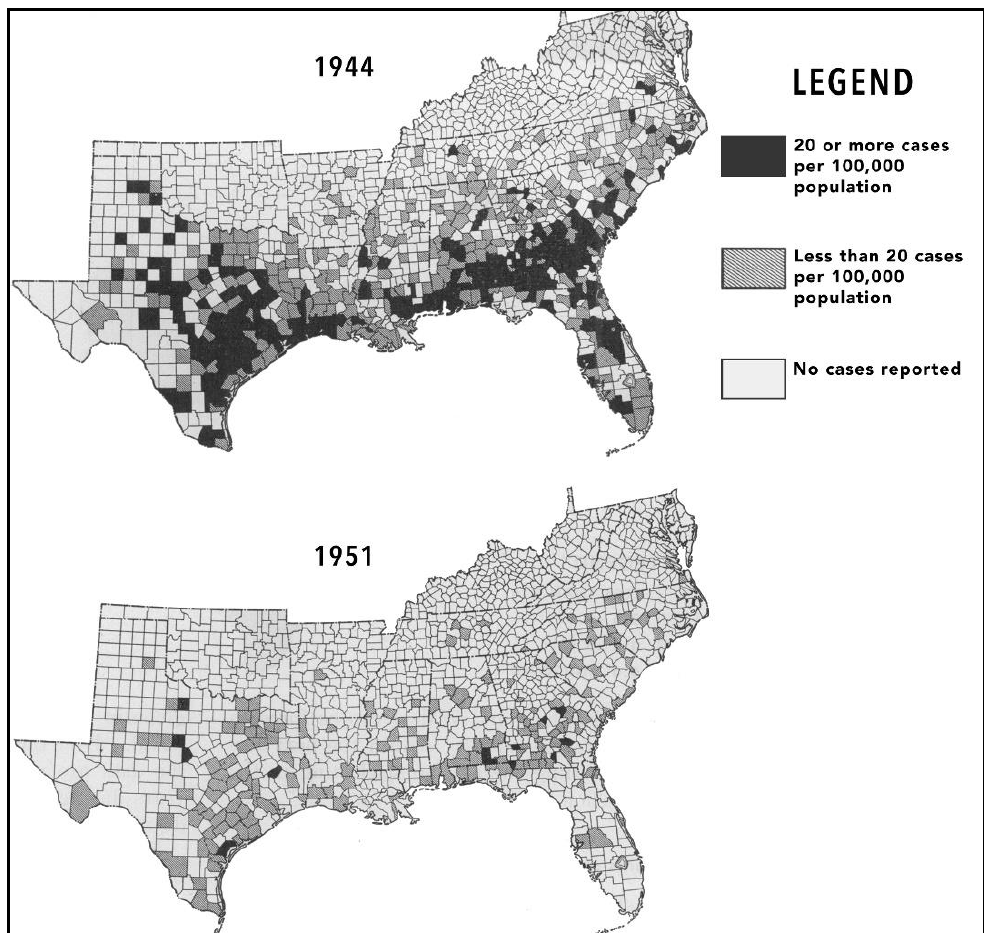
Figure 7. Map showing decreasing cases and geographic contraction of FBT in the United States from 1944 to 1951